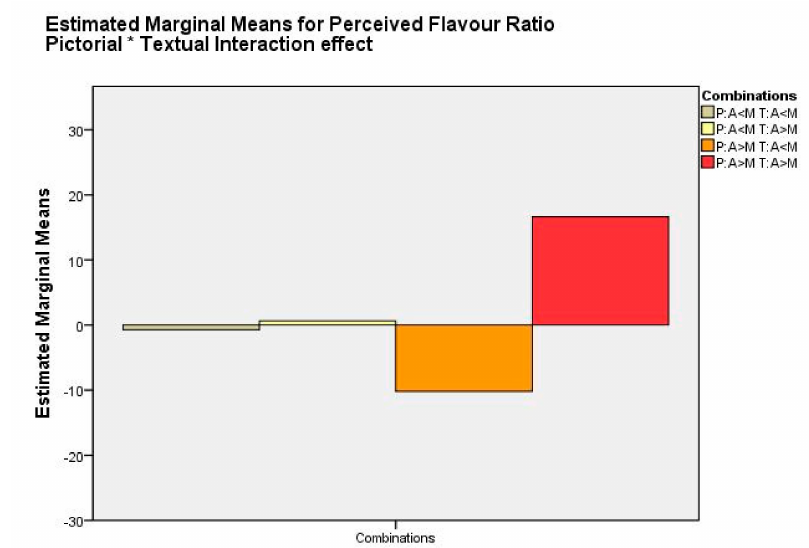
Figure 3. Perceived flavor ratio of di ff erent FOP images for the di ff erent ingredient lists shown. Note: P stands for pictorial, T stands for textual, A < M stands for dominant mango, A > M stands for dominant